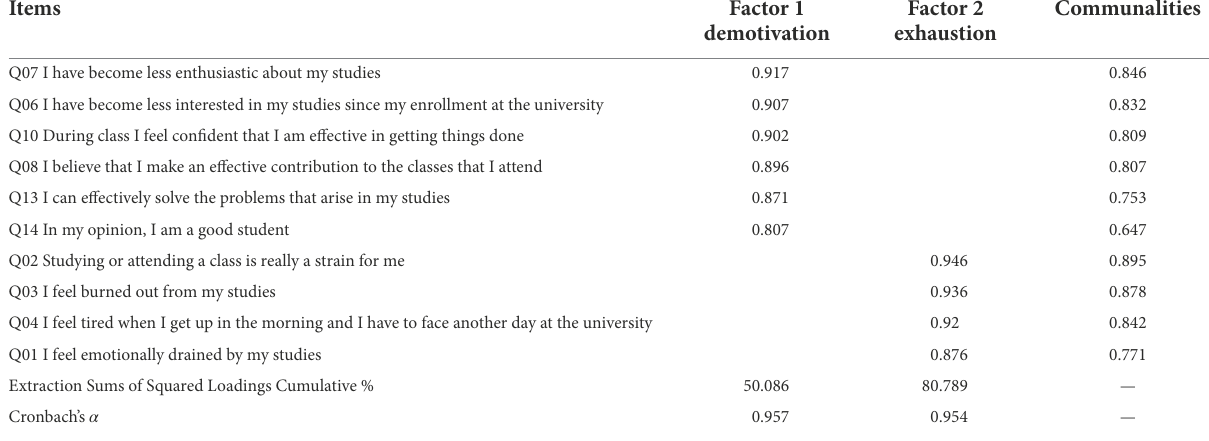
TABLE 1 Factor analysis of English learning burnout (pattern